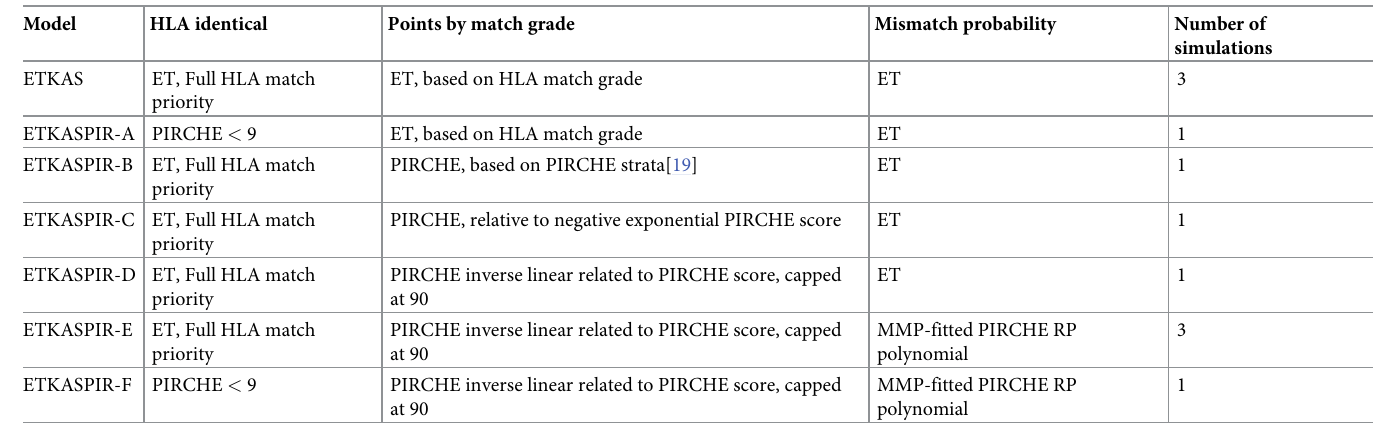
Table 1. Description of the allocation simulation